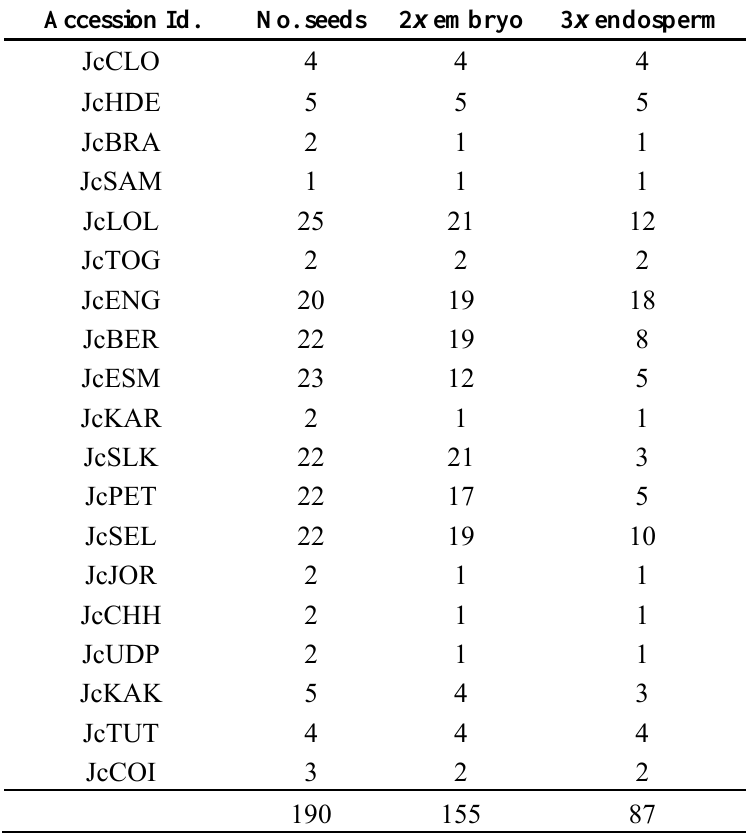
Table 6. Results of the flow cytometric screening of J. curcas seeds. Information on accessions and number of analyzed seeds per population is given along with the number of embryos and endosperm successfully evaluated for the DNA contents of their nuclei. Accession Id. No. seeds 2 x embryo 3 x endosperm JcCLO